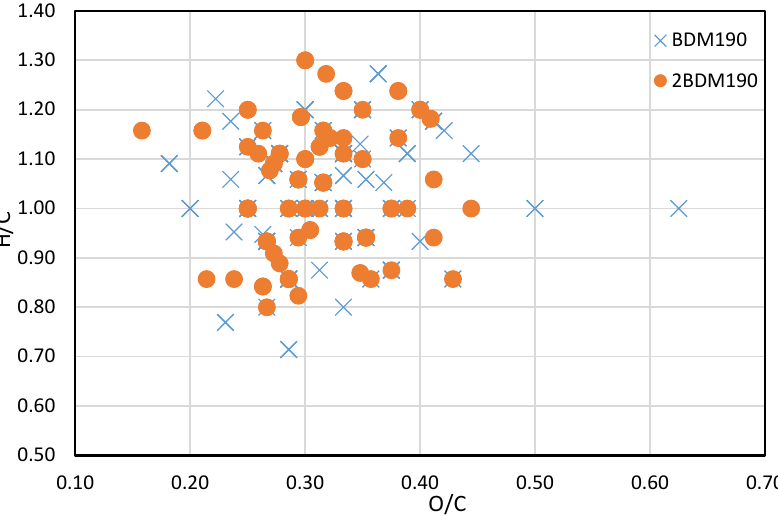
Figure 4. Van Krevelen plot of BDM190 and 2BDM190 samples.